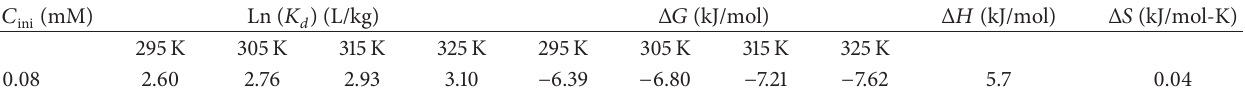
Table 1: Thermodynamic values of SDZ adsorption on zeolite at different temperatures.